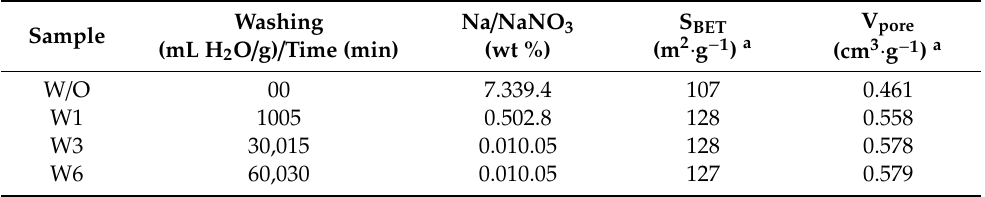
Table 1. Nomenclature, Na content (inductively coupled plasma atomic emission spectroscopy (ICP-EAS)) and textural properties (form N 2 isotherms) of the hydroxycarbonate precursors.